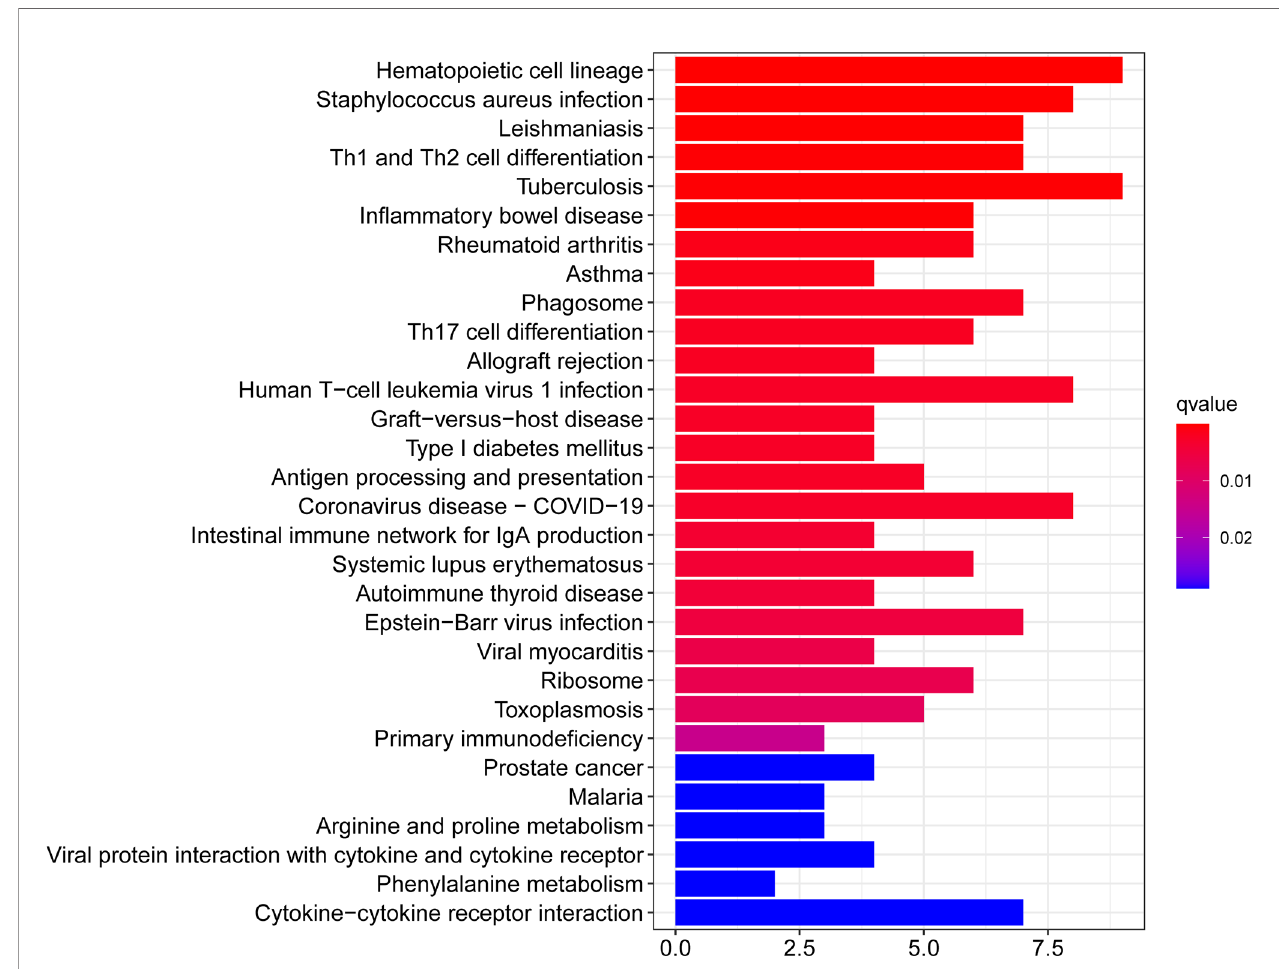
FIGURE 4 | The bar graphs of pathway enrichment analysis of the common DEGs between COVID-19 and RA performed by KEGG 2021 human